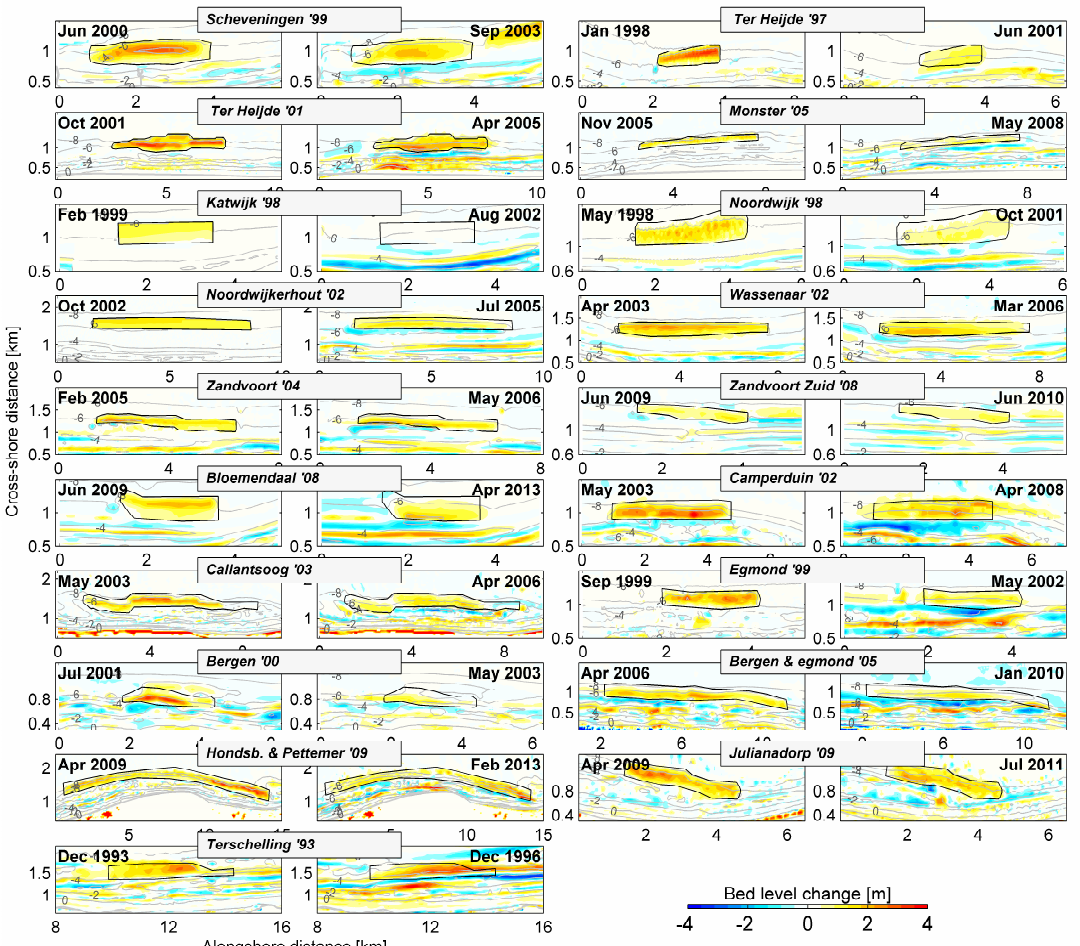
Figure 5. Bathymetric change of 19 nourishments with respect to the pre-construction situation for a moment shortly after construction (1st and 3rd column) and after 2 to 6 years (2nd and 4th column). The initial nourishment region is demarcated with a black line. Depth contours are indicated as gray lines with depth annotations with respect to MSL. The horizontal and vertical directions correspond with the alongshore and cross-shore direction, with the landward side at the bottom of each plot (the right side is northeast). Note that the scale has been distorted to fit the